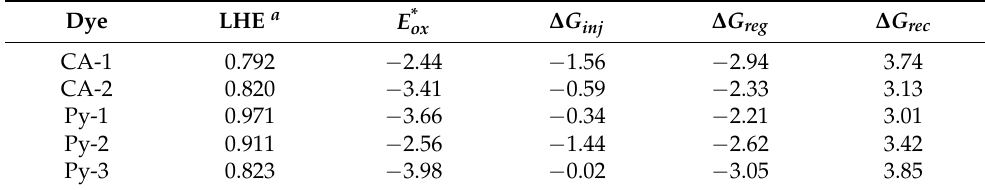
Table 5. Estimated light harvesting efficiency (LHF) and critical energy parameters (in